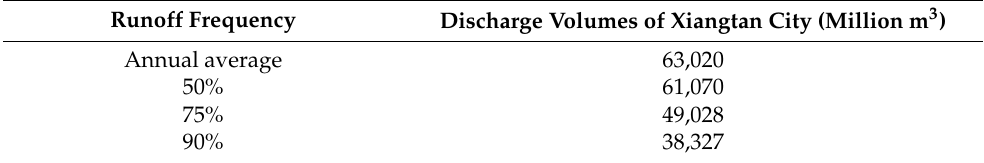
Table 2. The discharge volumes of Xiangjiang River Section-Xiangtan City under different runoff